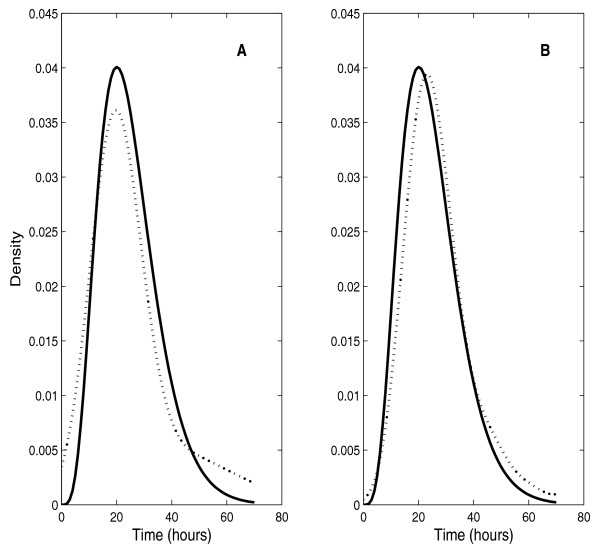
(A) The only case where the null hypothesis is rejected when a gamma distribution density is fitted to observed times to mitotic division; (B) An example where the null hypothesis is not rejected when a gamma distribution density is fitted to observed times to division.